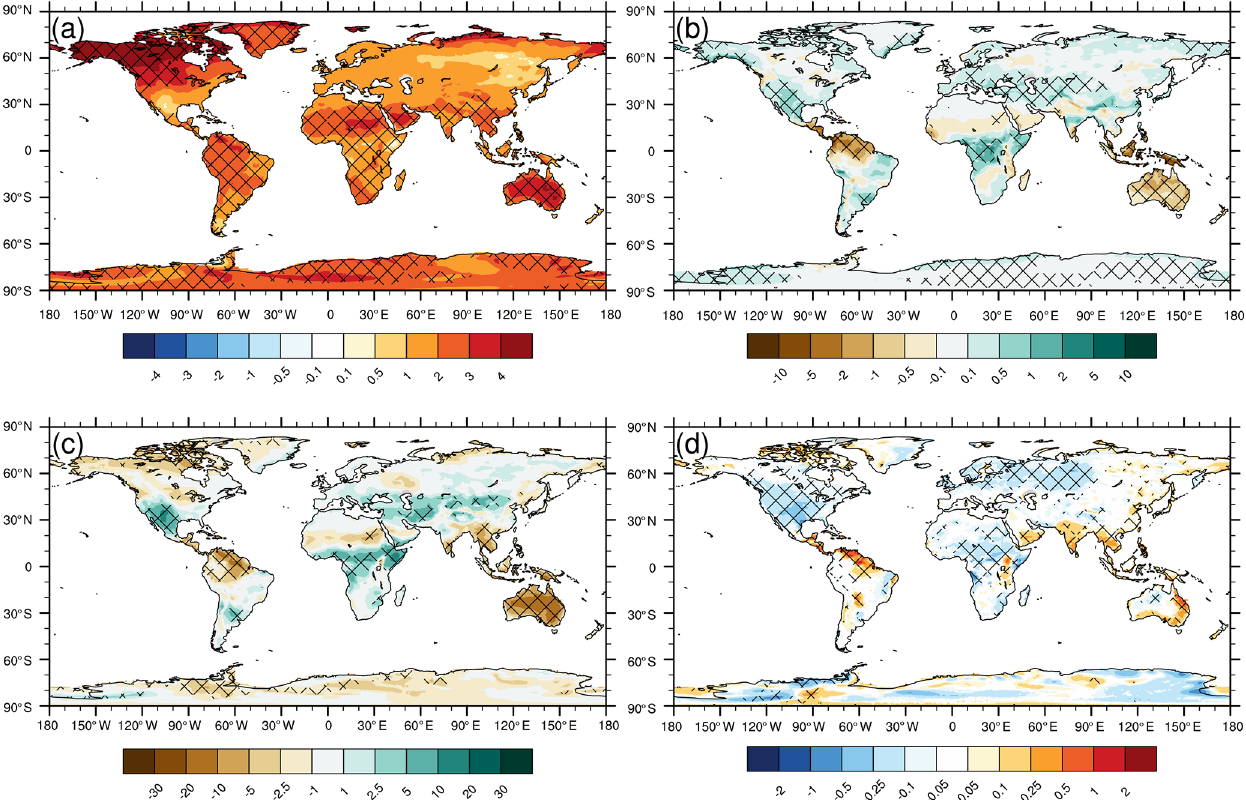
Figure 9. CESM-RESFire-simulated changes in fire weather variables between the RCP4.5 future scenario and the present-day scenario (CTRL2–CTRL1). (a) Changes in surface temperature (K); (b) changes in total precipitation rate (mmd − 1 ); (c) changes in surface relative humidity (%); (d) changes in surface wind speed (ms − 1 ). The hatching denotes the 0.05 significance level. For clear comparison with fire changes in Figs. 7 and 8, only fire weather changes over land are